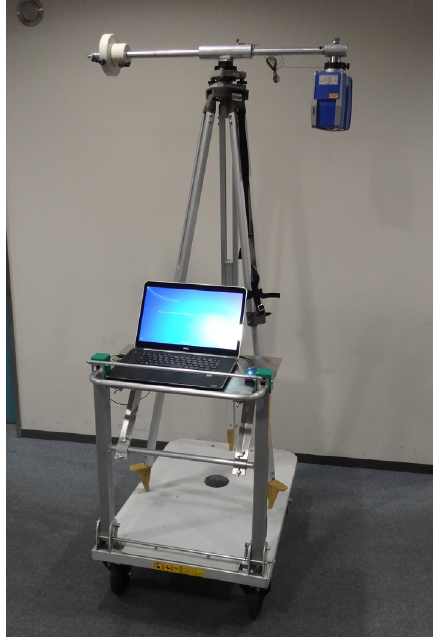
Figure 21. Hardware with a suspended